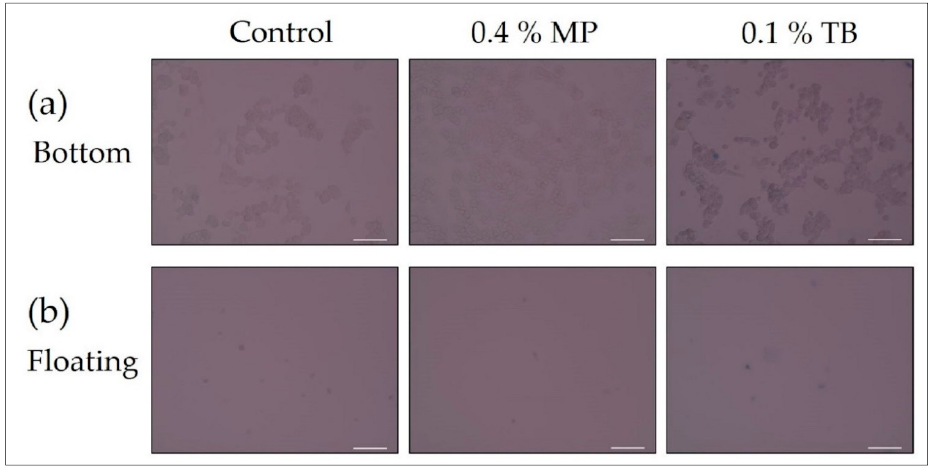
Figure 5. Confirmation of noninvasiveness of pigment (47 h pigment immersion). ( a ) Cells on the bottom of dishes; ( b ) Floating cells. All scale bars designate 100 μ m.